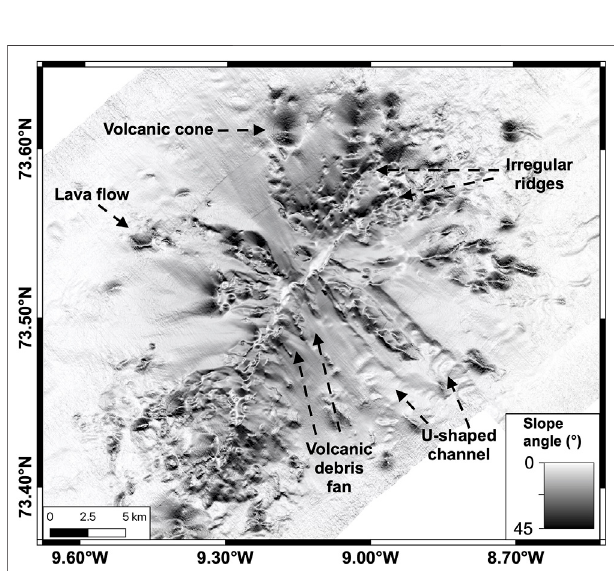
FIGURE 5 | Map of the slope angles of the Vesteris Seamount with various volcanic structures labeled.